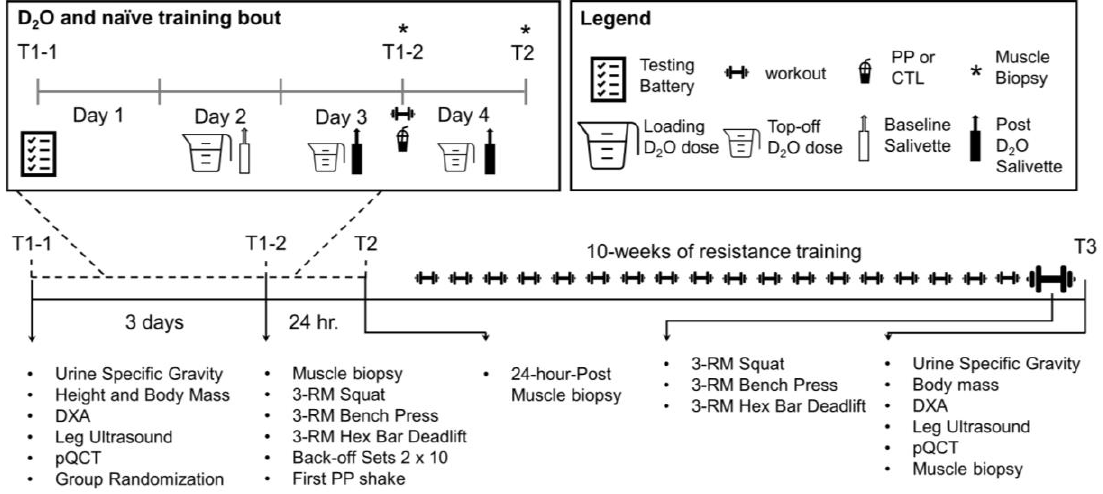
Figure 1. Study design. The figure above outlines the study